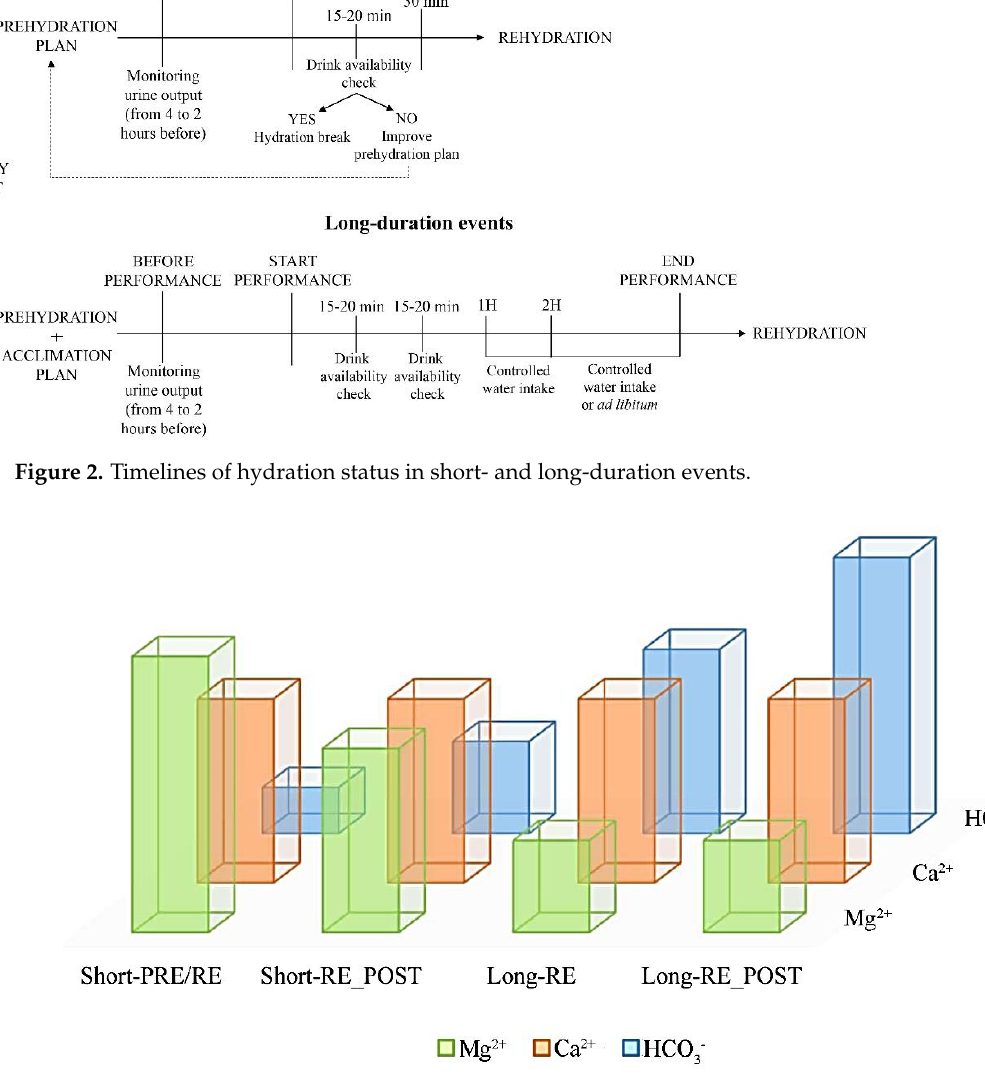
Figure 3. Natural Mineral Spring Waters composition before, during and after short- and long- duration sport events. The relative distribution of magnesium, calcium, and bicarbonate is re- ported for a qualitative evaluation of the best composition of the waters. Short-PRE/RE = prehy- dration/rehydration before/during short-duration events; Short-RE_POST = rehydration post-exer- cise (recovery time) in short-duration events; Long-RE = rehydration during long-duration events; Long-RE_POST = rehydration post-exercise (recovery time) in long-duration events; Mg 2+ = mag- nesium; Ca 2+ = calcium; HCO 3 − = bicarbonate.